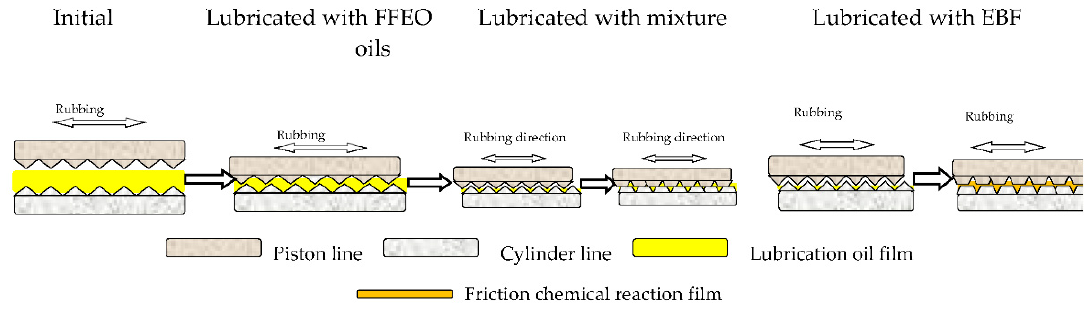
Figure 10. Schematic of the wear behaviours of cylinder liners and piston rings lubricated with different oils.